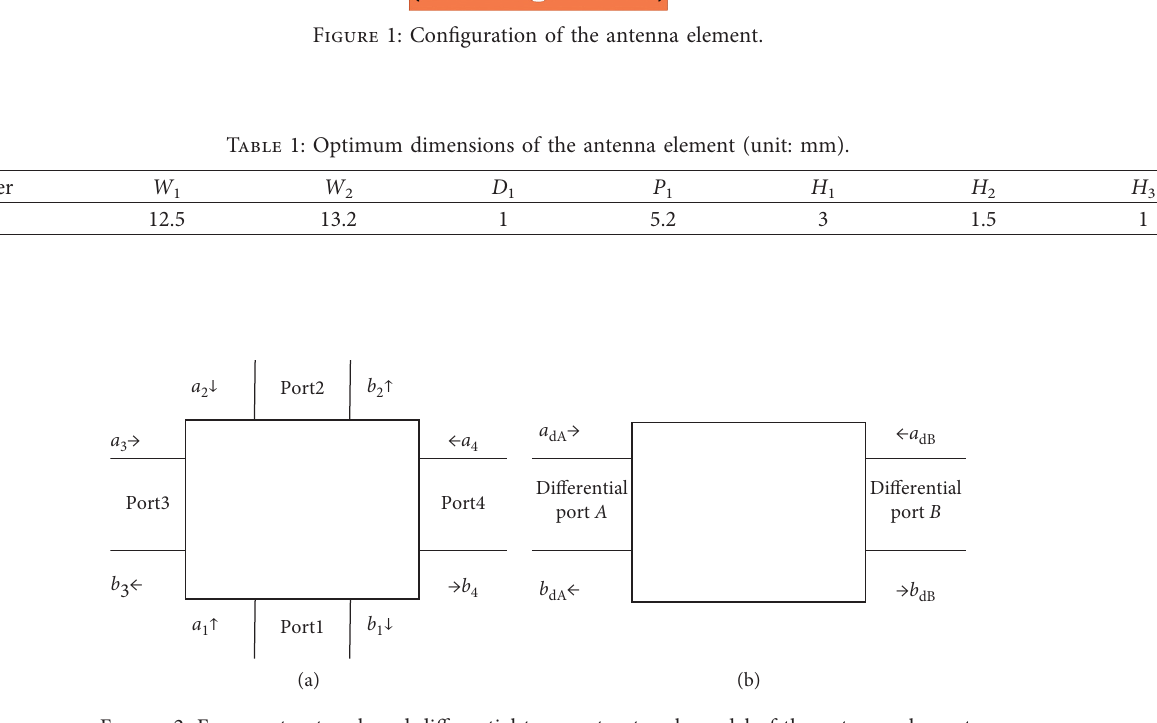
Figure 2: Four-port network and differential two-port network model of the antenna